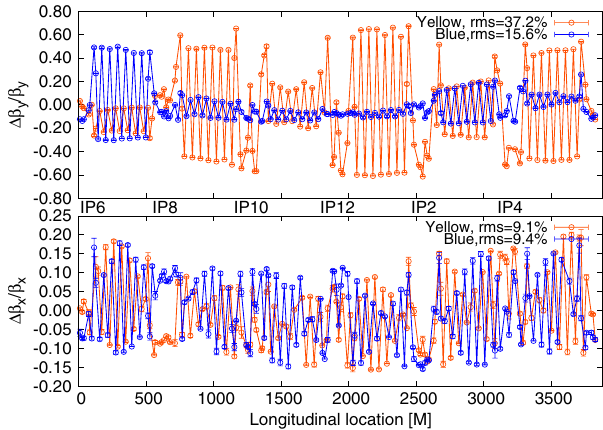
FIG. 1. Measured beta-beat with error bars in the horizontal (bottom) and vertical (top) plane for both rings at RHIC. A peak beta-beat of approximately 15% is observed in the horizontal plane for both rings. A 30% vertical peak beta-beat is found in the Blue ring and 60% in the Yellow